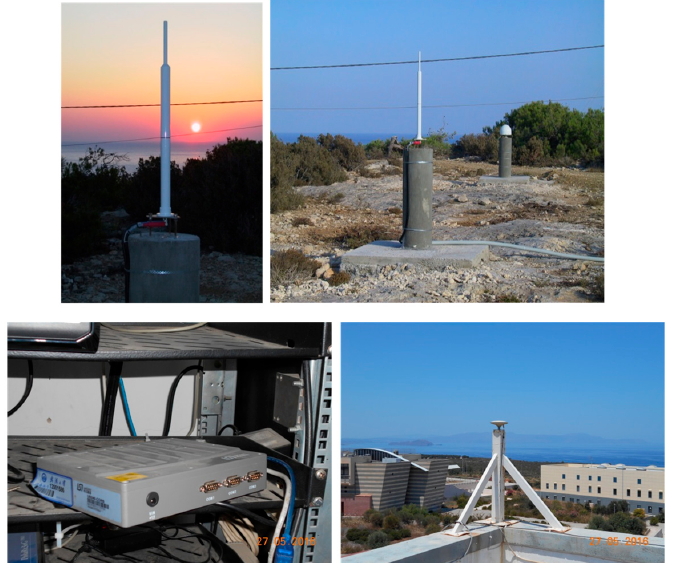
Figure 11. The DORIS beacon was installed in Gavdos calibration facility (above left) and collocated with a GNSS receiver (above right). The photos in the lower part of this Figure show the operating BeiDou station in the Technical University of Crete, Greece.